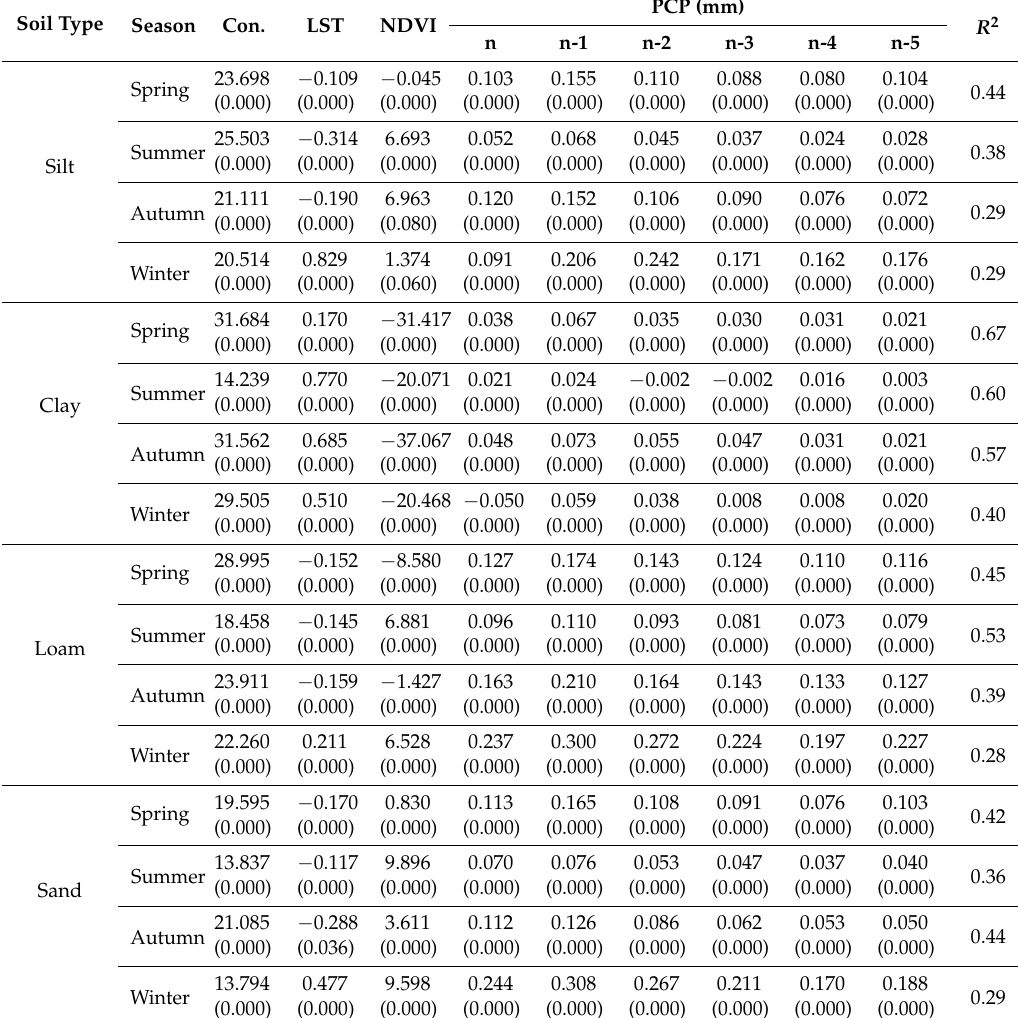
Table 5. Regression coefficients in four seasons and for four soil